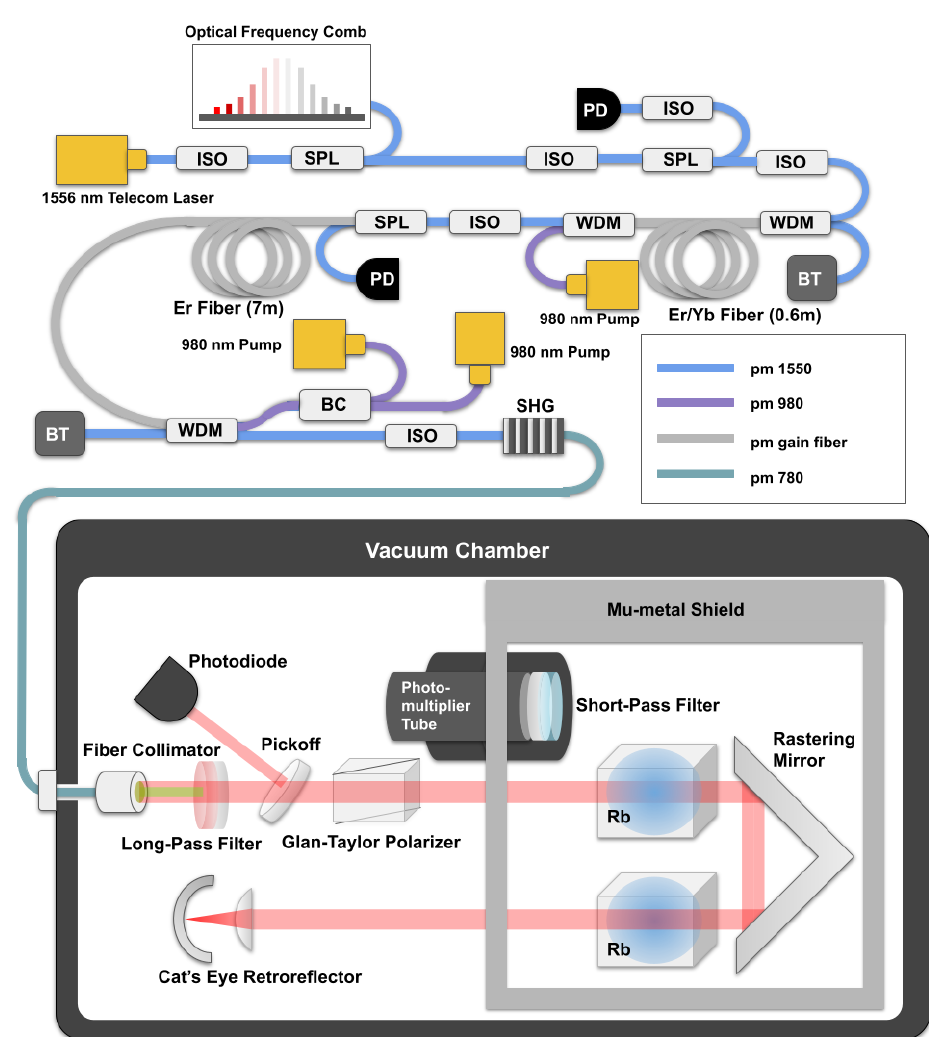
Figure 1. Diagram of the two-photon clock. Laser light at 1556 nm is amplified, frequency doubled, and delivered by optical fiber into a vacuum chamber via a vacuum feedthrough. From there, the light is launched into free space and encounters a filter, pickoff (for monitoring power), and polarizer before entering the vapor cells. A cat’s eye retroreflector returns the beam anti-parallel to create counter-propagating beams. A photomultiplier tube (PMT) monitors for 420 nm fluorescence from the Rb atoms. An optical frequency comb (OFC) divides the laser frequency optical frequency down to an RF signal. ISO: isolator. SPL: splitter. WDM: wavelength division multiplexer. BT: beam terminator. BC: beam coupler. PD: photodiode. SHG: second harmonic